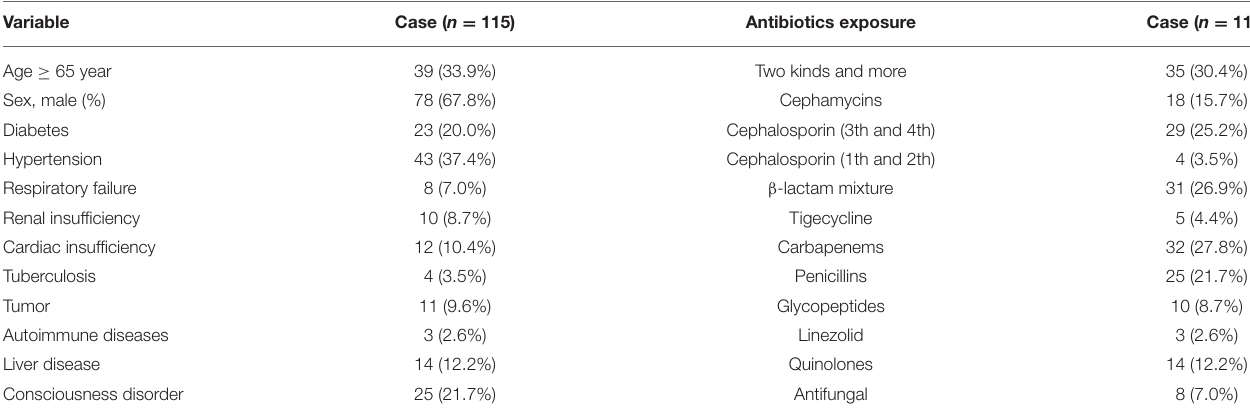
TABLE 2 | Clinical features and antibiotics exposure of the CDI